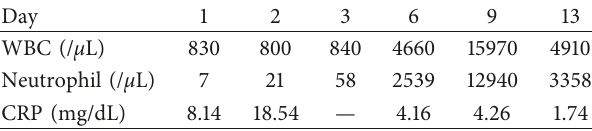
Table 2: Change in laboratory data after